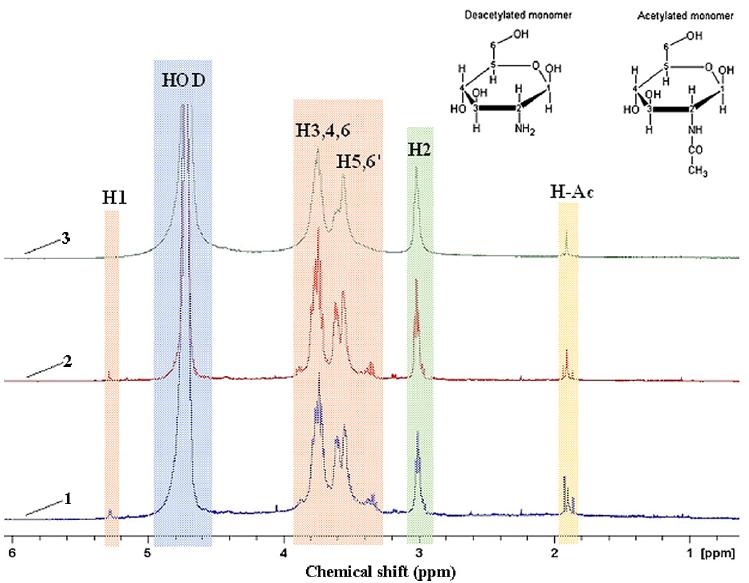
Figure A1. The 1 H NMR spectrum of the original chitosan (1) and chitosan treated in oxygen EBP for 5 min (2) and 10 min (3). The scheme of the protons in the chitin/chitosan unit is also included in the